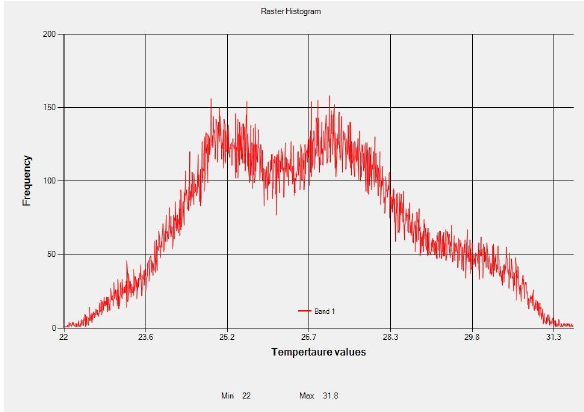
Figure 8. The Raster IR Histogram